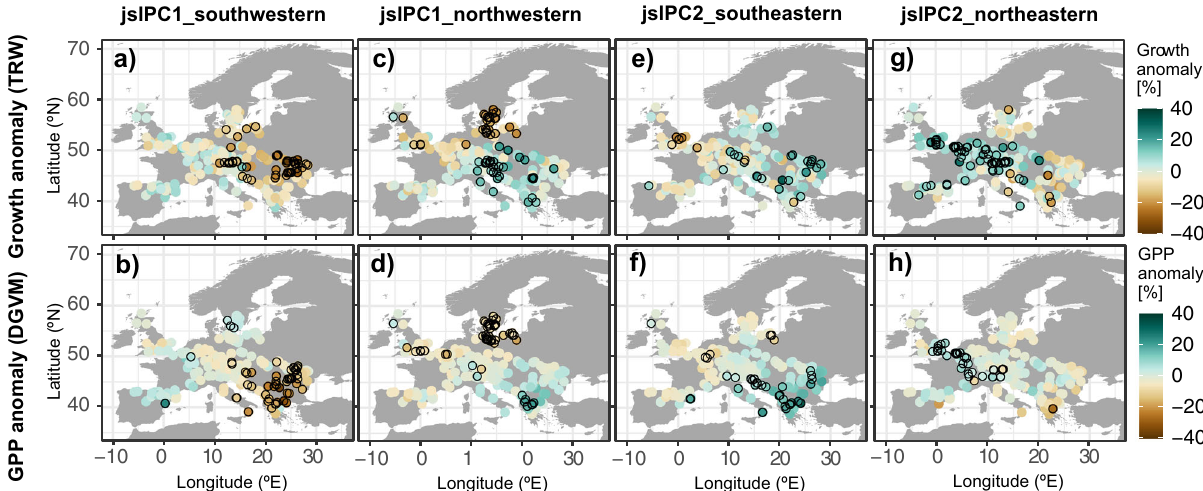
Fig. 2 European beech radial growth and forest productivity during summer JSL extremes. Anomalies in European beech radial growth ( a , c , e , g ) and DGVM-estimated forest GPP ( b , d , f , h ) for the years showing the largest summer JSL anomalies (i.e., D90 and D10 of jslPC1 and jslPC2 scores, see Supplementary Table 1). Anomalies are expressed as percentages from the mean for the period 1950 – 2005. Black circles indicate signi fi cant anomalies ( p <